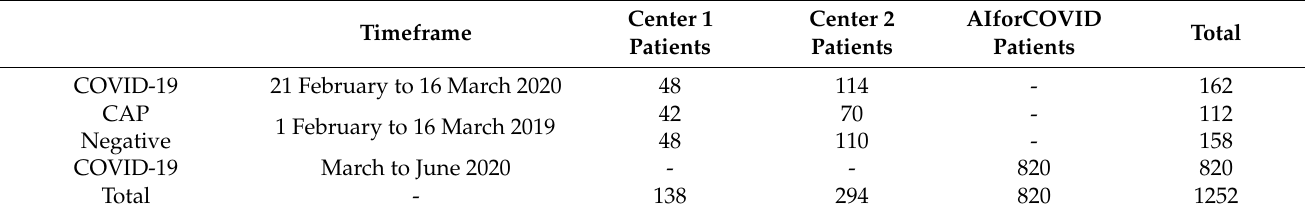
Table 1. Patients’ distribution among the included datasets.